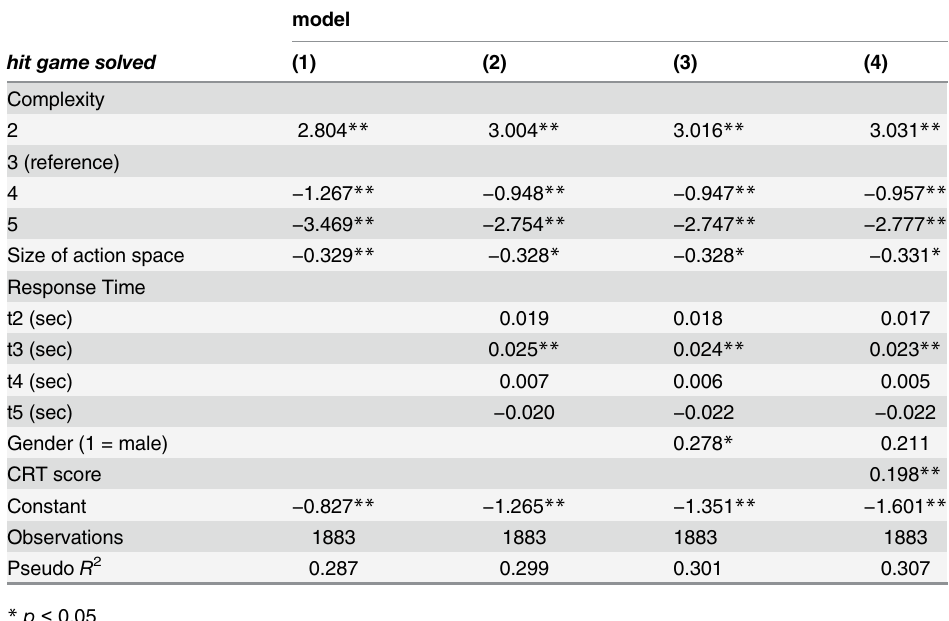
Table 5. Logit regressions on solving a hit